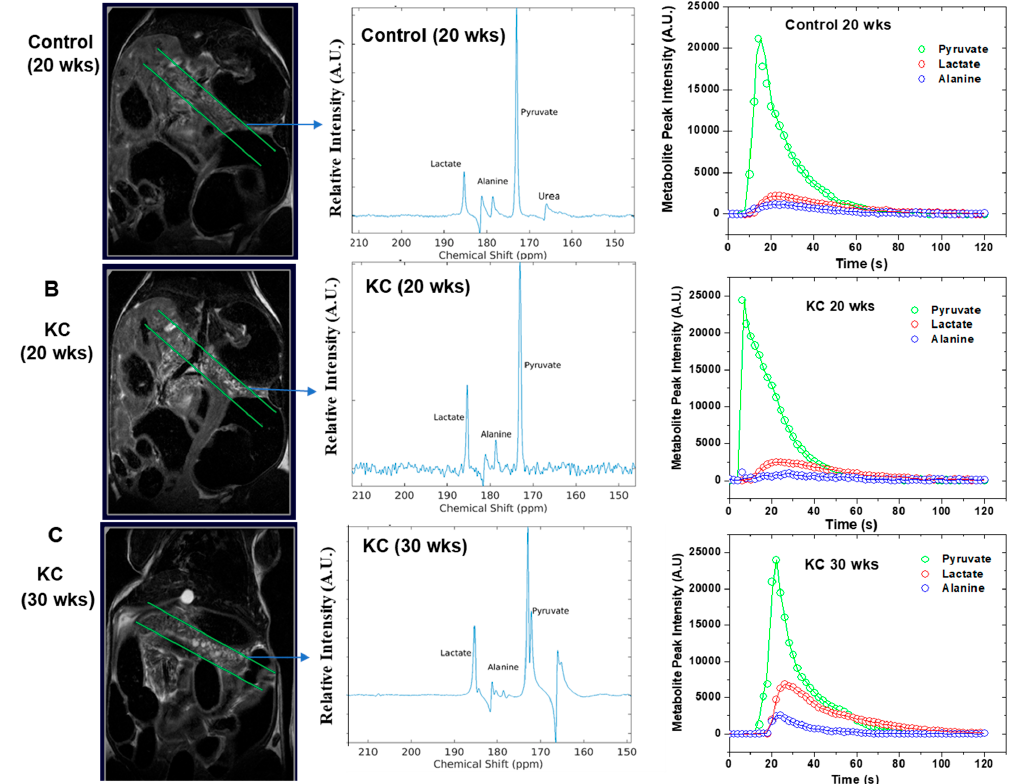
Figure 3. T 2 -weighted coronal MR image, in vivo 13 C MR spectra (acquired from selected slabs) and normalized signal intensity of different metabolites presented for ( A ) control mice with 20 weeks of age, ( B ) KC mice with an age of 20 weeks, and ( C ) KC mice with an age of 30 weeks. MRI images depict the smaller number of nodules on early stage PanINs ( B ) and the number and the size of the nodules increase as the PanINs progress to advanced stages ( C ). The real-time 13 C MR spectra were acquired in vivo following injection of hyperpolarized pyruvate. The lactate production is significantly higher in advanced PanINs. The time evolution of all three metabolites was captured up to two minutes, and the experimental data were fitted to unidirectional kinetic modelling ( C ) for apparent rate constants k PA and k PL determination. The fitted parameters are summarized in Table 1.